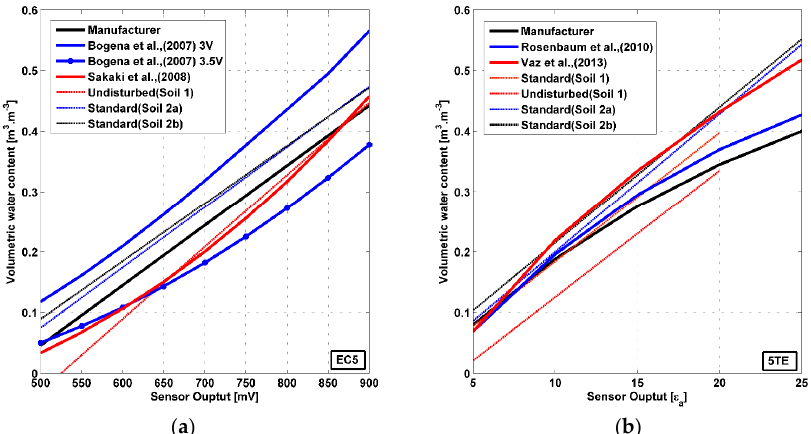
Figure 8. Comparison of different calibration procedures reported in the literature for the EC5 ( a ) as well as for the 5TE sensor ( b ).